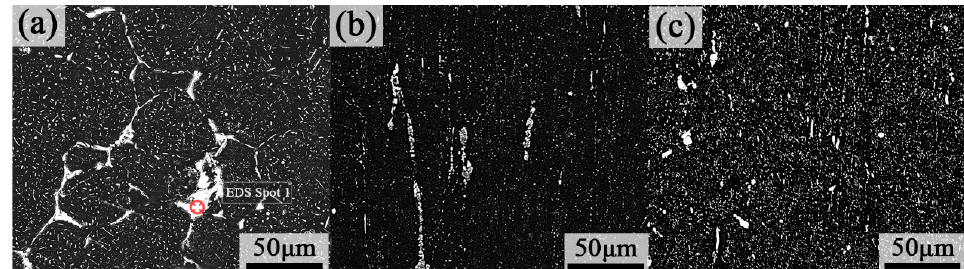
Figure 6. Backscattered electron micrographs ( a ) homogenization state, ( b ) after pre-deformation, and ( c ) after angular extrusion deformation of the annular channel.